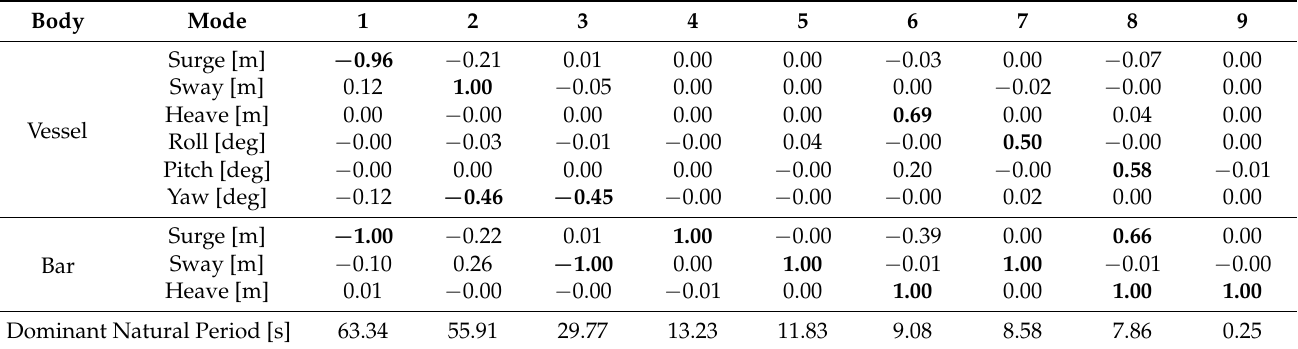
Table 8. Eigenvalues and natural periods of rigid body motions of coupled vessel-spreader bar system.